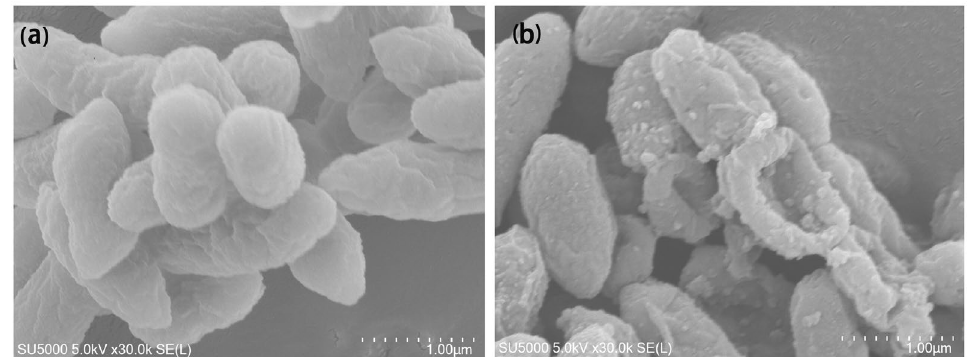
Figure 11. Scanning electron micrograph of E. coli before ( a ) and after ( b ) M-NH 2 -CIT@CIT